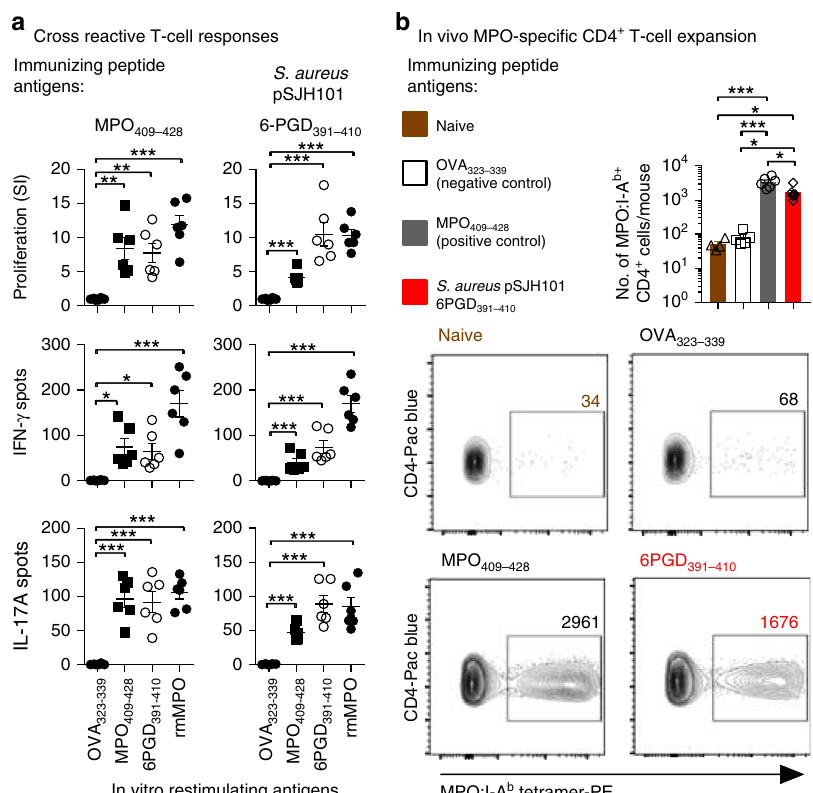
Fig. 2 Immunization with S. aureus pSJH101-derived 6PGD 391 – 410 induces anti-MPO T-cell responses. a C57BL/6 mice ( n = 6 each group) were immunized with either MPO 409 – 428 or S. aureus pSJH101-derived 6PGD 391 – 410 , then T-cell responses measured ex vivo to either OVA 323 – 339 , MPO 409 – 428 , 6PGD 391 – 410 , or recombinant mouse MPO (rmMPO) using [ 3 H]-thymidine proliferation assays (top row), and ELISPOT for IFN- γ (middle row) or IL-17A (bottom row). Each dot represents one mouse; data are representative of two independent experiments. b In vivo expansion of MPO-speci fi c CD4 + T cells. Cells from lymph nodes and spleen of C57BL/6 mice, either naive ( n = 4), immunized with OVA 323 – 339 ( n = 5), MPO 409 – 428 ( n = 6) or S. aureus pSJH101-derived 6PGD 391 – 410 ( n = 6). Results are expressed as number of MPO:I-A b tetramer + cells per mouse. Error bars represent the mean ± s.e.m. * P < 0.05, ** P < 0.01, *** P < 0.001 by Kruskal – Wallis test. Source data are provided as a Source Data fi